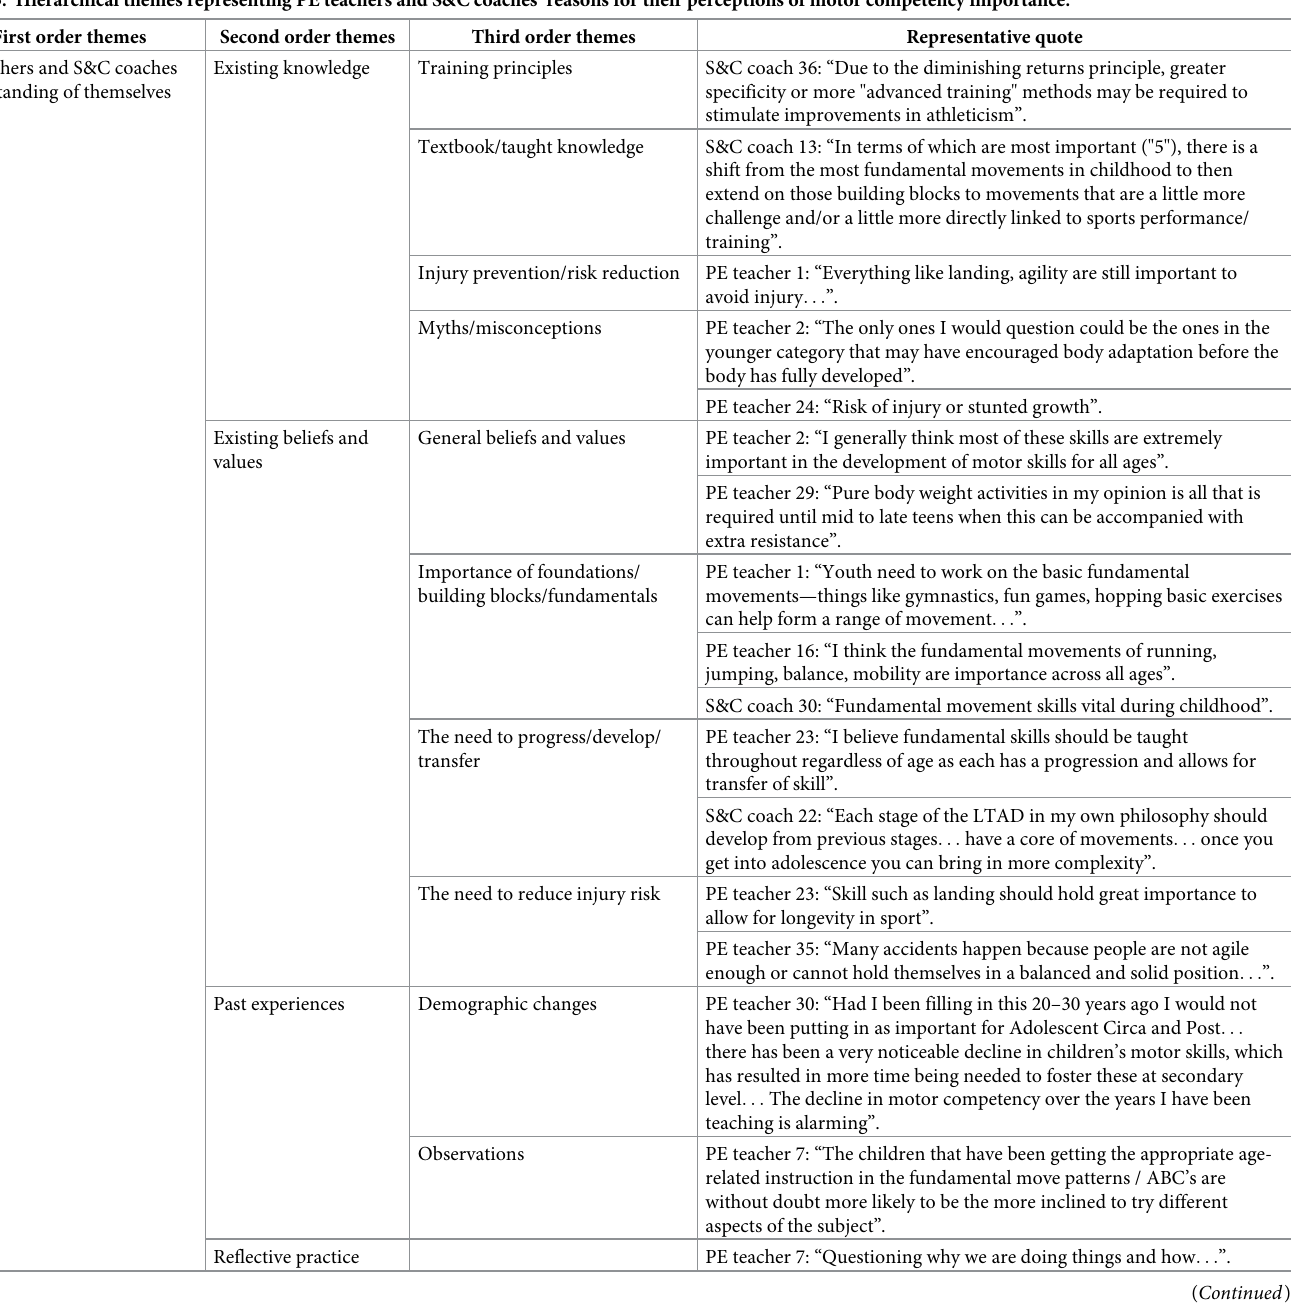
Table 3. Hierarchical themes representing PE teachers and S&C coaches’ reasons for their perceptions of motor competency